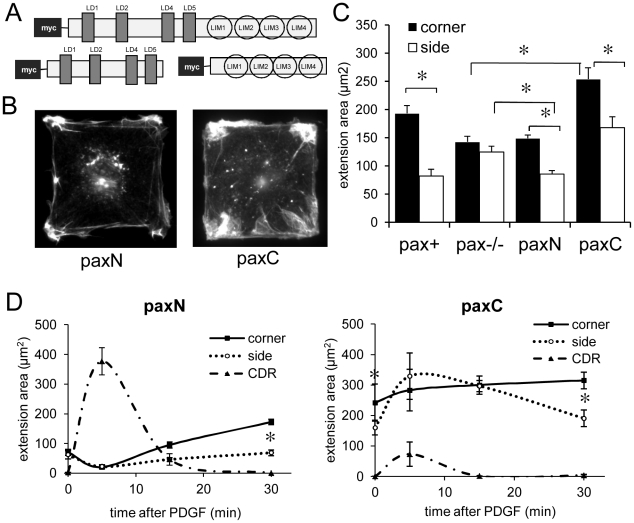
Expression of the N-terminal half of paxillin leads to suppression of side extensions and broad lamellipodia, whereas the C-terminus alone enhances lamellipodia formation.A) Schematic of the structure of the myc-tagged paxillin constructs expressed in pax+, paxN, and paxC MEFs. B) PaxN (left) and paxC (right) MEFs plated on 50×50 µm FN islands were treated with PDGF (25 ng/ml) for the indicated times, fixed, and stained with Alexa488-phalloidin to label F-actin. C) Quantification of corner and side extension areas in cells fixed 30 min after PDGF stimulation. Both paxN and paxC expression result in significant differences between corner and side extension areas. Side extension area is significantly reduced in paxN Cells compared to pax−/− cells, and corner extension area is enhanced in paxC cells compared to pax−/− cells. n>50 cells per genotype. * p<0.001. D) Spatiotemporal dynamics of membrane extension in paxN and paxC cells fixed at 0, 5, 15, and 30 min after addition of PDGF. PaxN cells (left) mainly form CDRs at 5 min, then extend small corner-localized protrusions by 30 min. PaxC cells (right) form corner lamellipodia even in the absence of PDGF, which induces transient lateral membrane extension. n>20 cells per genotype. * p<0.01 between corner and side extension areas.